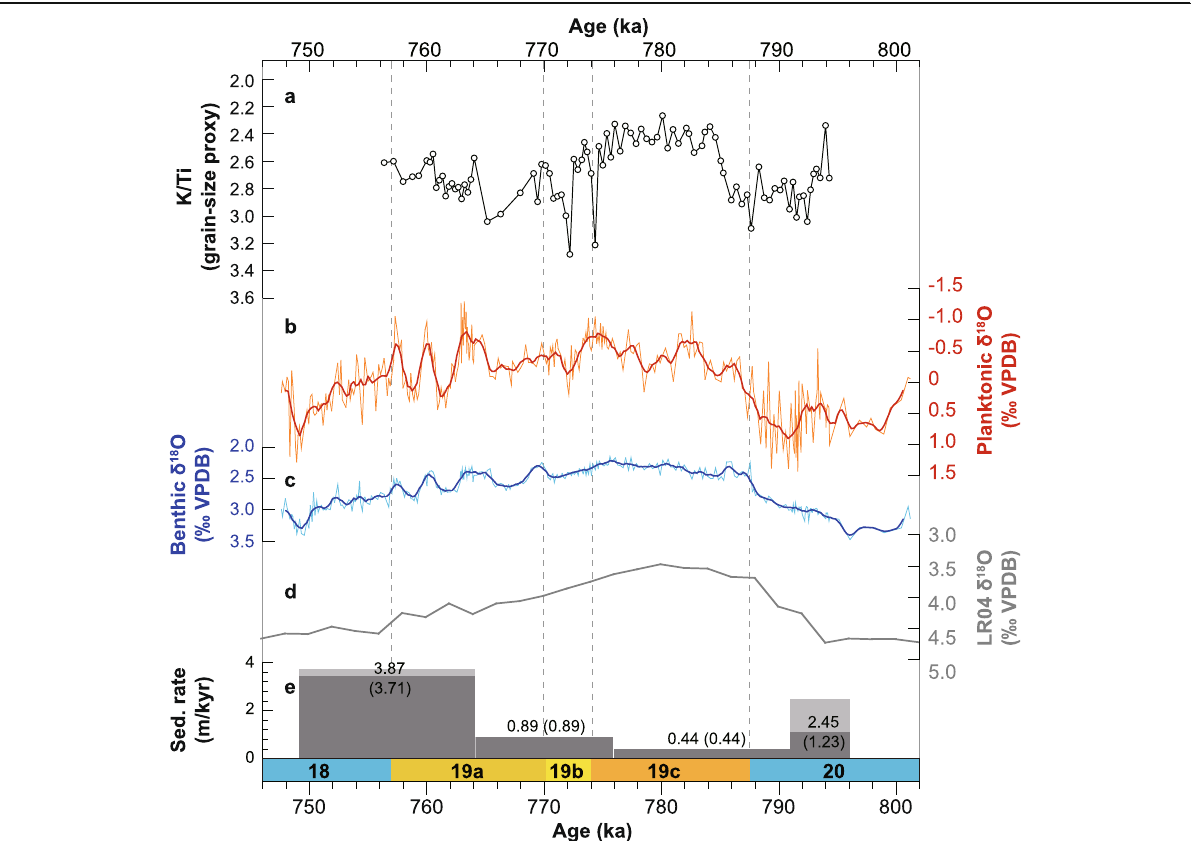
Fig. 6 Temporal changes in sedimentological parameters from MIS 20 to MIS 18 at the CbCS. a K/Ti record obtained by TATSCAN-F2, which is interpreted as a grain-size proxy (see details in the text). Note the smaller K/Ti value indicates coarser sediment. b High-resolution δ 18 O records from planktonic ( Globigerina bulloides ) and c benthic foraminifers at the CbCS (Haneda et al. 2020b). Thick lines are 1000 yr moving average profiles. d The LR04 benthic stack (Lisiecki and Raymo 2005). e Calculated sedimentation rate variation at the CbCS (after Suganuma et al. 2018) with (light gray bars) and without (dark gray bars) sandstone beds. Detailed information on the age model is given in Suganuma et al. (2018). Dashed lines are Marine Isotope Stage and substage boundaries, based on Haneda et al.